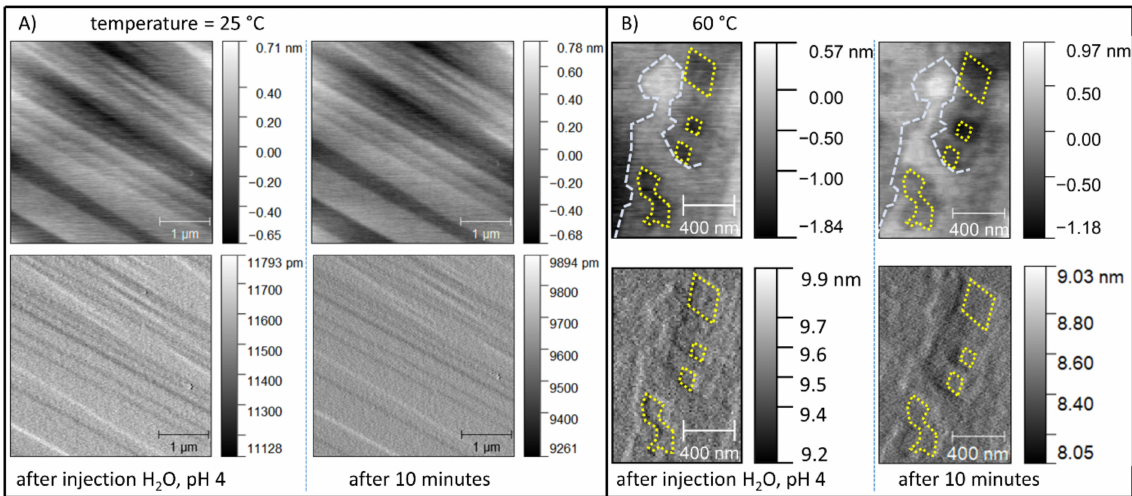
Figure 8. In situ observation of {10.4} surfaces of MGS in contact with acidic solution, pH 4 (HNO 3 ). The images were acquired in tapping mode. The first row corresponds to height channels, while the second row reports the respective amplitude channels. ( A ) The dissolution at 25 ◦ C is sluggish and it is not possible to detect any dissolution feature. ( B ) In the same conditions but at higher temperature (60 ◦ C), dissolution features are observed on the {10.4} surfaces of MGS, despite the retrograde solubility. Yellow and blue lines of constant size are used to highlight the evolution of etch pits and step edges, respectively. This evidence demonstrates that the existence of kinetic barriers controls the dissolution of MGS at room temperature